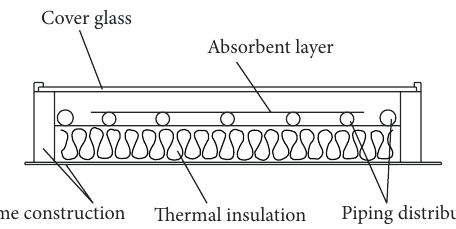
Figure 1: Diagram of a flat-plate